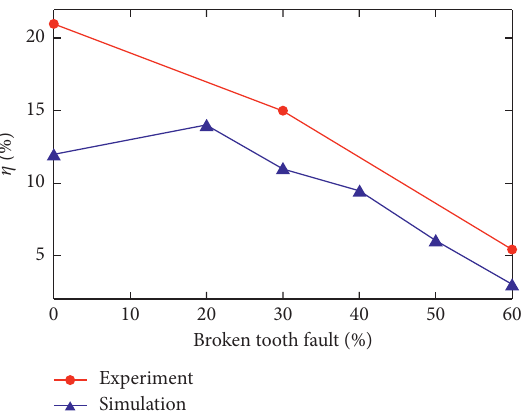
Figure 13: Influence of time-varying friction excitation on low-frequency band.